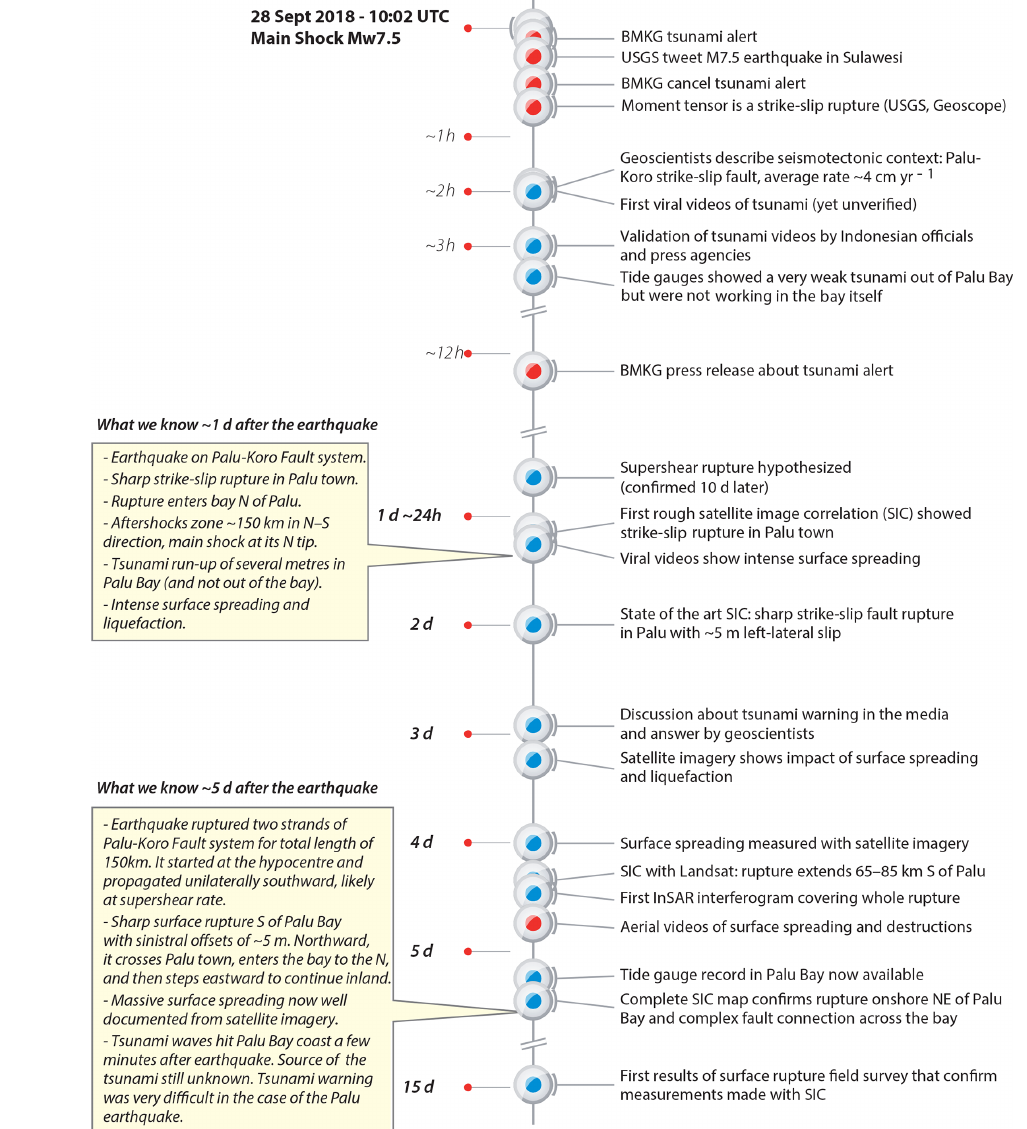
Figure 1. Timeline of information posted on Twitter in the hours and days following the Palu earthquake and tsunami of 28 September 2018. The timeline illustrates the acquisition and dissemination of observations regarding geophysical events and the progress of knowledge build- ing via Twitter. See Table A1 for detailed information on the timing; Table S1 in the Supplement provides links to relevant tweets and Twitter accounts; Figs. 2 and 3 display examples of tweets posted by geoscientists. Red dots correspond to information posted by responding agencies, and blue dots correspond to observations and discussions posted by researchers from different countries and